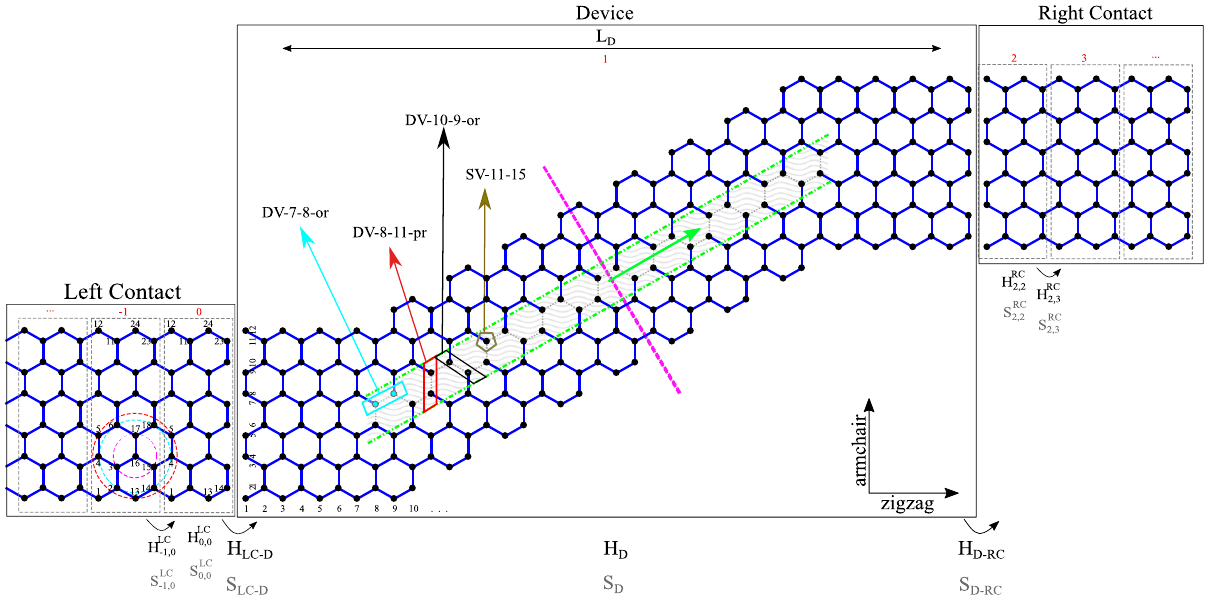
Figure 1. A schematic of the model implemented in the NEGF method with all Hamiltonians and overlap matrices. Vacancies are relocated in the hatched area, and four vacancies with their names are shown. The thick purple dashed line indicates the middle of the device section. Three concentric circles show the first, second, and third nearest-neighbor domains, respectively, by magenta, cyan, and red colors for a selected atom. Vacancies were considered in different places in the hatched area (the green arrow shows this direction). Numbers in the device were used for this purpose as described in the